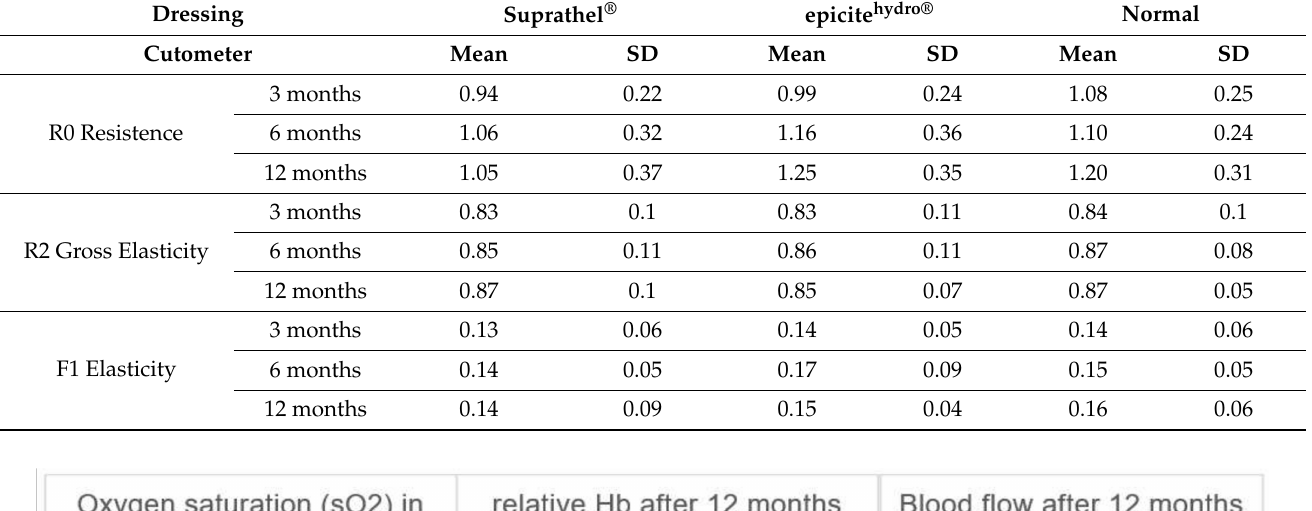
Table 1. Cutometer measurements mean and SD (standard derivation) after 3,6 and 12 months of treated and untreated areas R0 in mm; F1 in area under the curve and R2 in %.